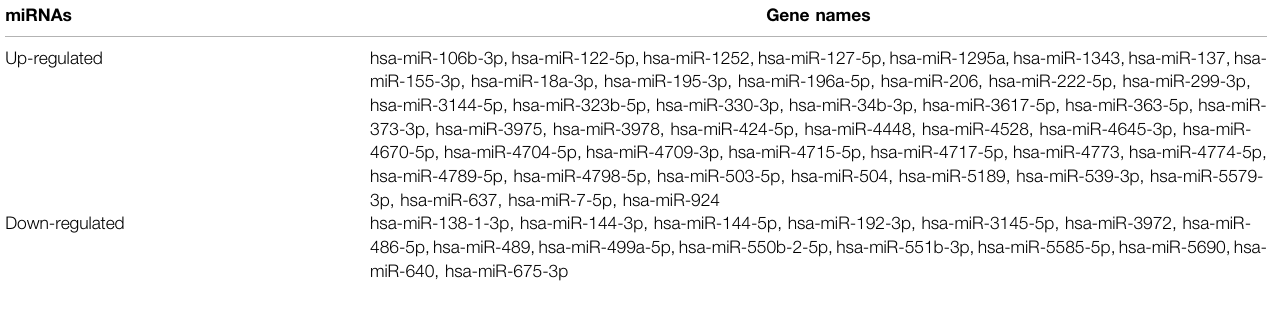
TABLE2| FifetyninedifferentialexpressedmiRNAswereidenti fi edfrommiRNApro fi les(GSE59974dataset),including44upregulatedgenesand15down-regulatedgenes in the ESCC responder groups compared with control groups. miRNAs